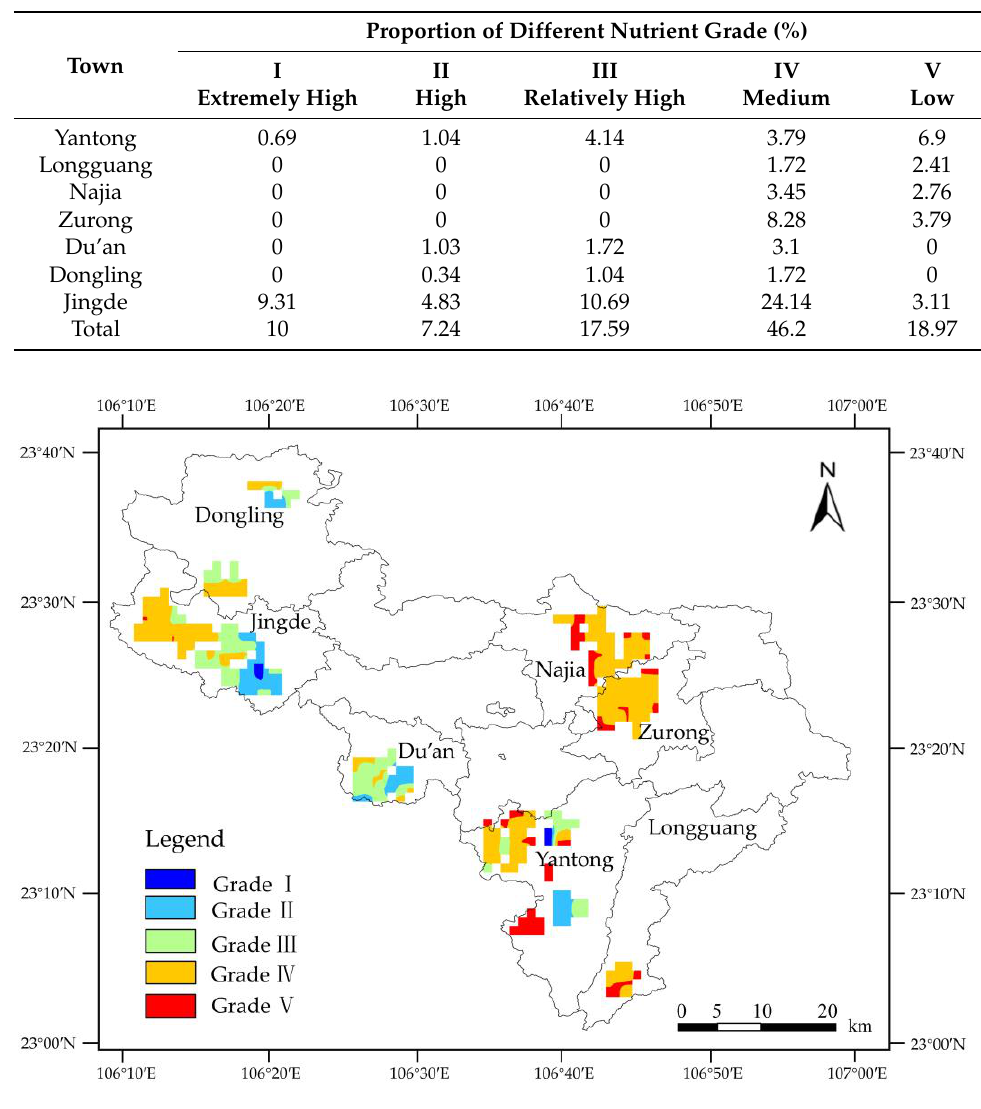
Figure 6. Spatial distribution of soil fertility.